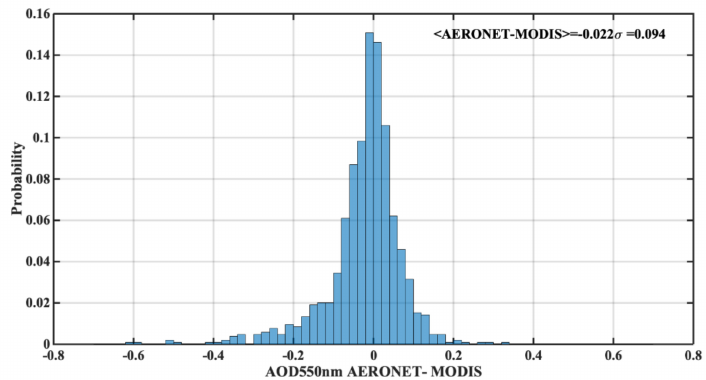
Figure 1. Comparison between AOD at 550 nm from MODIS with the corresponding measurements from AERONET, for CUT-TEPAK.